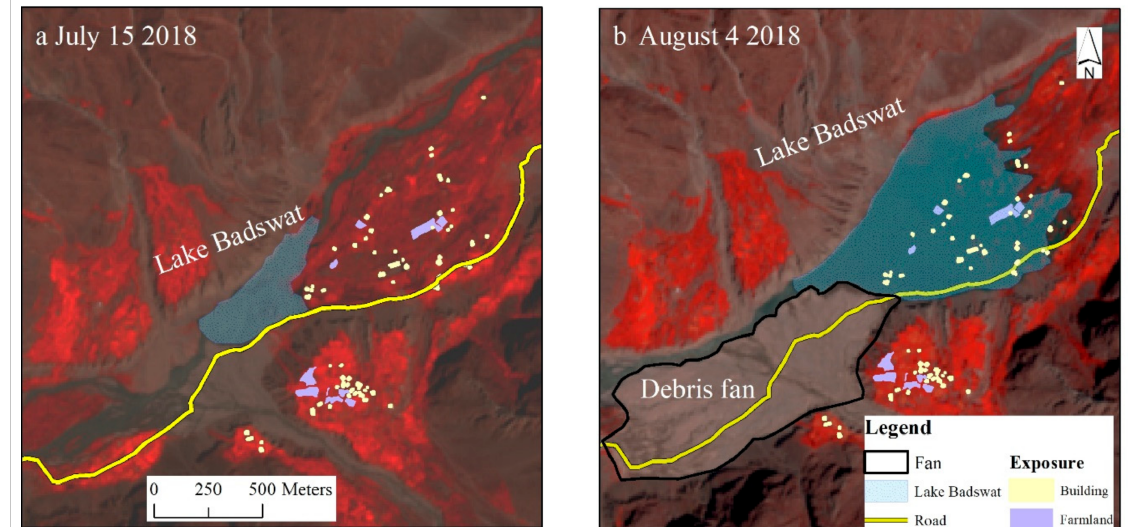
Figure 6. Surface exposure before and after the event. ( a ) Before the event (the background image is from Sentinel 2, acquired on 15 July 2018). ( b ) After the event (the background image is from Sentinel 2, acquired on 4 August